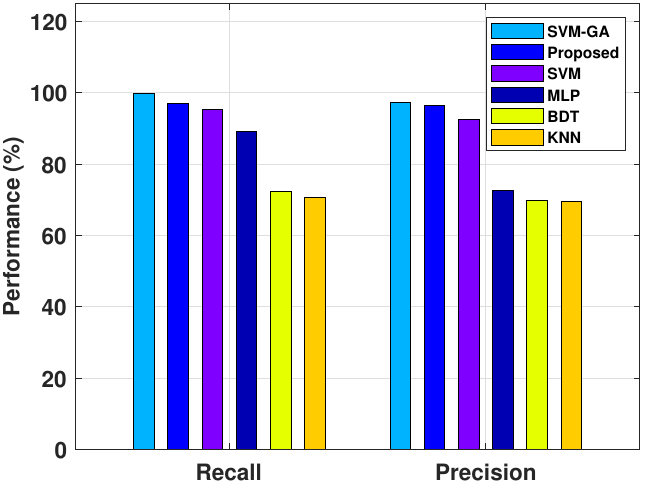
Figure 5. Performance comparison for gas recognition